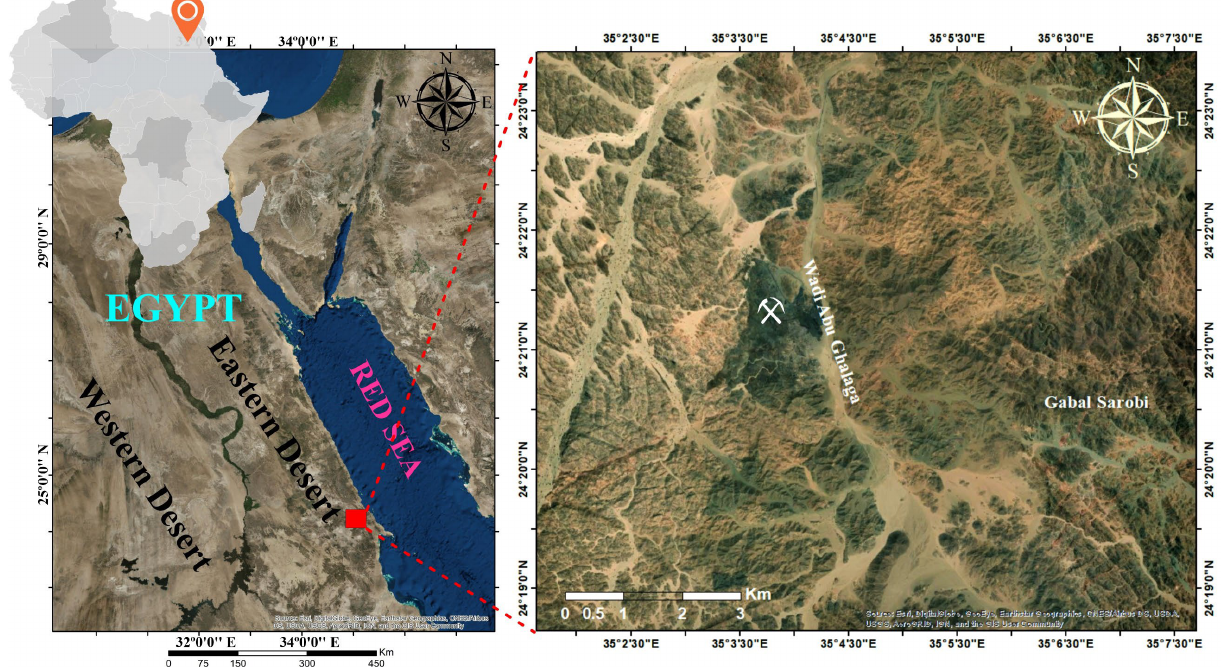
Figure 1. Location map of the Abu Ghalaga district, Egypt, on a Google-based map. This region (south-eastern desert, Egypt) has been subjected to several regional tectonic movements and magma intrusion, as evidenced by xenolith, particularly the fractures that impacted the gabbroic rocks, allowing ilmenite to disseminate. The present studied area is affected by two principal shear zones [11]: the Nugrus shear zone (NSZ) and the South Hafafit suture (SHS). The Nugrus shear zone (NSZ) is an NW-trending zone of mylonite, schists, and small bodies of gnessic granitoids that runs from the Wadi Nugrus–Wadi Shait junction at the Hafafit complex’s tip to Wadi Abu Ghalaga, a distance of 77 km (Figure 2a,b). The NSZ is represented on most provincial geological maps continuing to the Red Sea Coast at Wadi Ranga, providing an overall length of 85 km [12,13]. The area consists mainly of metavolcanics, gabbroic rocks, and gneissose granites (granodiorite and tonalite), as well as late tectonic intrusions associated with a great deal of mafic to felsic dykes and quartz veins [14]; see Figure 3. The gabbroic rocks are considered as one of the main host rock types of Fe-Ti ore deposits and contain the famous ilmenite ore. The Abu Ghalaga ilmenite ore occurs in the southern part of the Abu Ghalaga gabbroic intrusion cropping out along the western bank of Wadi Abu Ghalaga (Figure 3). The Abu Ghalaga mine has the largest Fe-Ti ore reserve in Egypt [15,16]. Vanadium is one of the important elements associated with the Fe-Ti ore, and it was recorded in some analyses from 0.29 to 0.79 wt.% [3,17,18]. The main V carriers in these deposits are generally titanium-rich magnetite and ulvöspinel and ilmenite [18].